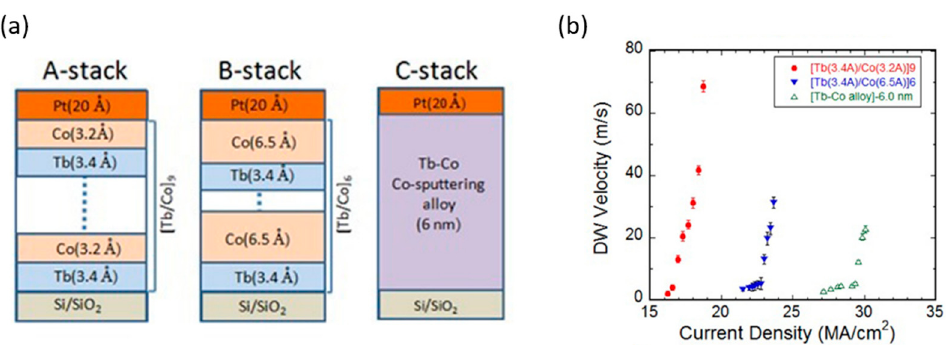
Figure 12. ( a ) Different Tb–Co ML and alloy structures with perpendicular magnetic anisotropy, ( b ) Current density dependence of DW velocity for magnetic wires with these structures. Reprinted with permission from ref. [84] 2016 APS .